Question: Briefly state, in one sentence, what is plotted here.
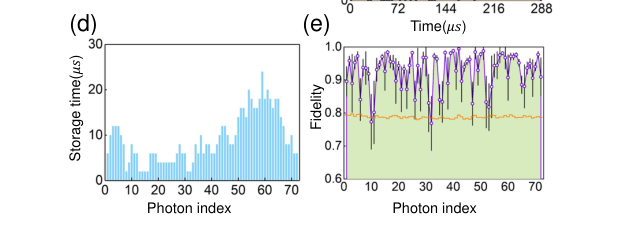
Answer: A general sequence for quantum queue. (a) A randomly generated sequence for quantum queue. (b) The input distribution and fidelity of 4 polarizations. (c) The filling number of the memory array during the experiment. (d) The storage time of 72 photons. (e) The fidelities of the retrieved photons and corresponding quantum bound (the orange lines). The error bars represent one standard devi- ation in both (b) and (e).